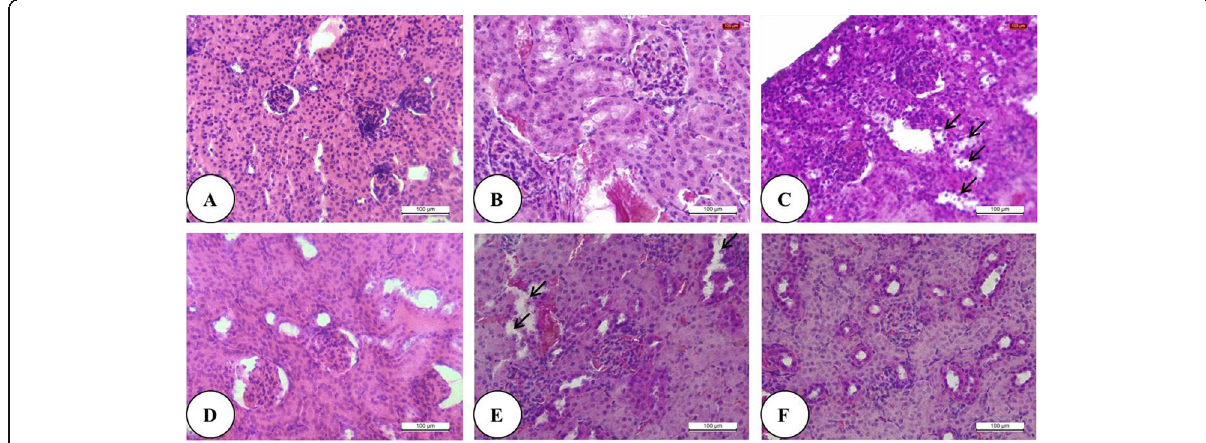
Fig. 9 Histopathology of kidney sections stained with hematoxylin and eosin. A NC group and B PC group showing normal kidney histology. C IRN group showing mild tubular damage. D GT group showing normal kidney histology. E IRN+GT Low group showing decrease tubular damage as compared to the IRN group. F IRN+GT High group showing normal kidney histology. (Arrow head represents tubular